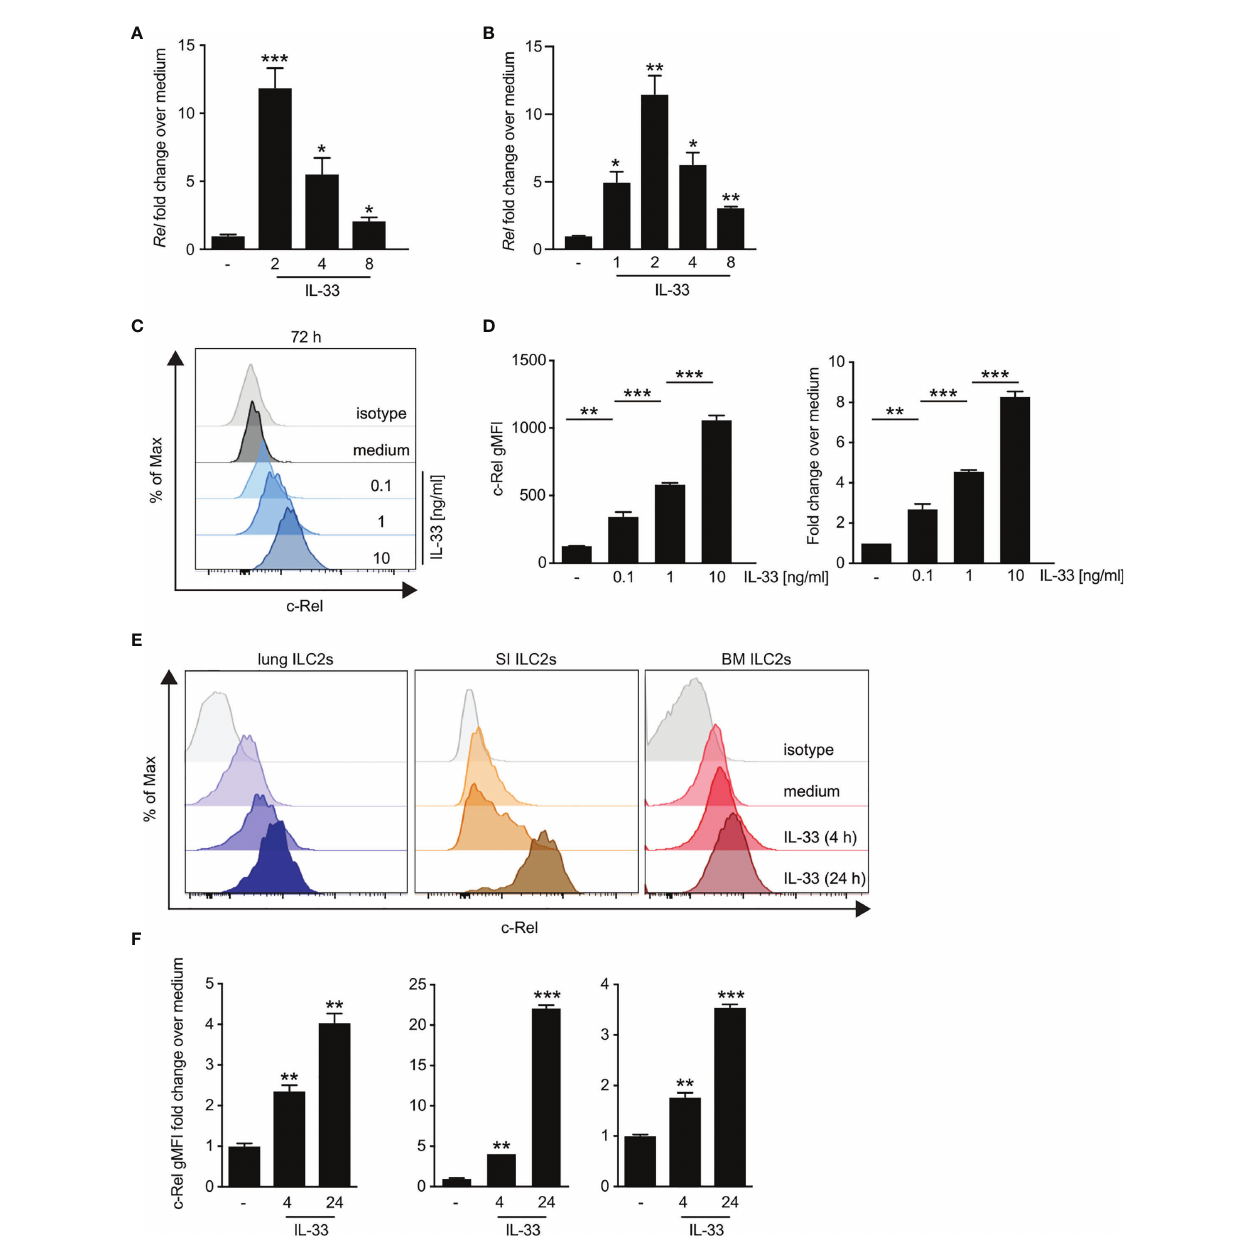
FIGURE 3 | IL-33-driven ex vivo activation of group 2 innate lymphoid cells (ILC2s) induces c-Rel expression. (A – D) Murine lung, small intestine, or bone marrow- derived ILC2s were isolated by fl ow cytometry and left unstimulated ( − ) or cultured in the presence of recombinant murine IL-33 for the indicated time points. Kinetics of c-Rel ( Rel ) transcript expression in (A) ex vivo expanded bone marrow-derived ILC2s stimulated with IL-33 (10 ng/ml) or (B) primary murine lung ILC2s. Asterisks indicate signi fi cance over untreated control. Transcript levels were assessed by qRT-PCR and are depicted as fold change over unstimulated ( − ) ILC2s. Asterisks indicate signi fi cance over untreated control. (C, D) Flow cytometric analysis of intracellular expression of c-Rel of isolated lung ILC2s after 72 h of ex vivo stimulation with medium ( − ) or IL-33 (0.1, 1, and 10 ng/ml). c-Rel staining is shown as (C) histogram plots in comparison with an isotype control antibody (gray), (D) gMFI (left panel), or fold change over unstimulated ILC2s (right panel). Asterisks indicate signi fi cance over unstimulated control. (E) Representative histogram plots of intracellular fl ow cytometric staining of c-Rel in lung (left), small intestine (middle), or bone marrow-derived (right) ILC2s left untreated (medium) or cultured with IL-33 (10 ng/ml) for 4 or 24 h. c-Rel staining is shown in comparison with staining with an isotype control antibody (gray). (F) c-Rel staining intensity in lung (left), small intestinal (middle), or bone-marrow-derived (right) ILC2s quanti fi ed as gMFI fold change over unstimulated cells. Asterisks indicate signi fi cance over respective untreated controls. Data are representative of at least two independent experiments including two or more biological replicates. Data are shown as mean ± SD with *p < 0.05, **p < 0.01, and ***p < 0.001 as determined by two-tailed t-test (unpaired). gMFI, geometric mean fl uorescence